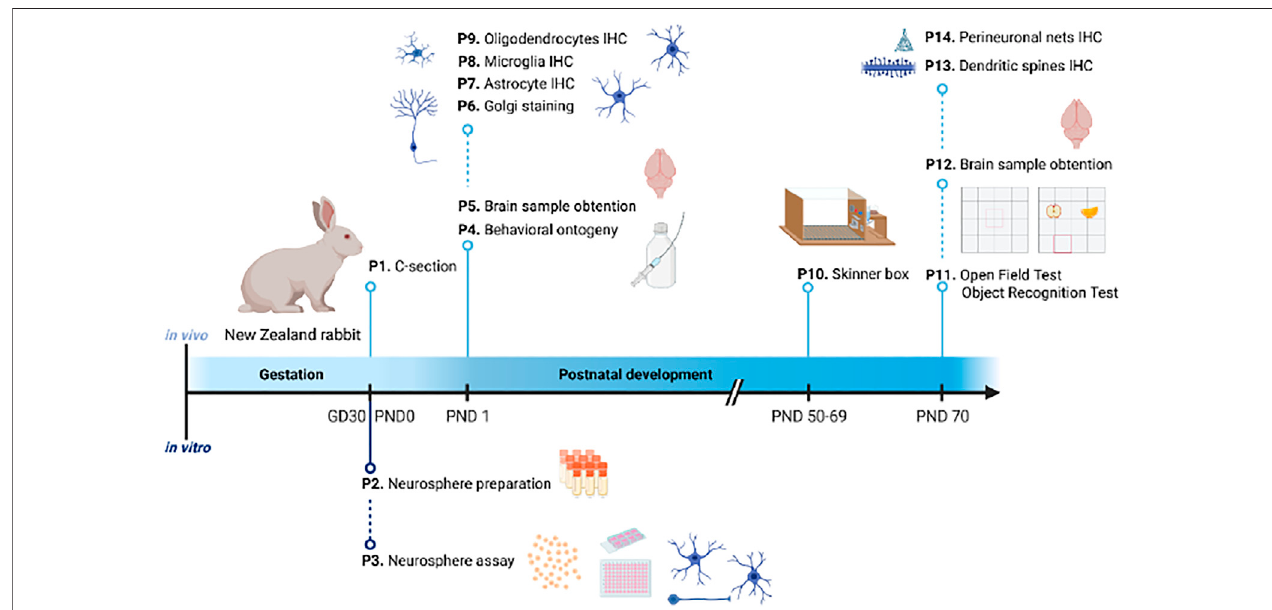
FIGURE1| Schematic representation ofthetimeline organization ofthe14protocols presentedin thispublication. Under thetimeline, protocols for in vitro testing; above the timeline, protocols for in vivo testing. GD: gestational day; IHC: immunohistochemistry; P: protocol; PND: postnatal day.